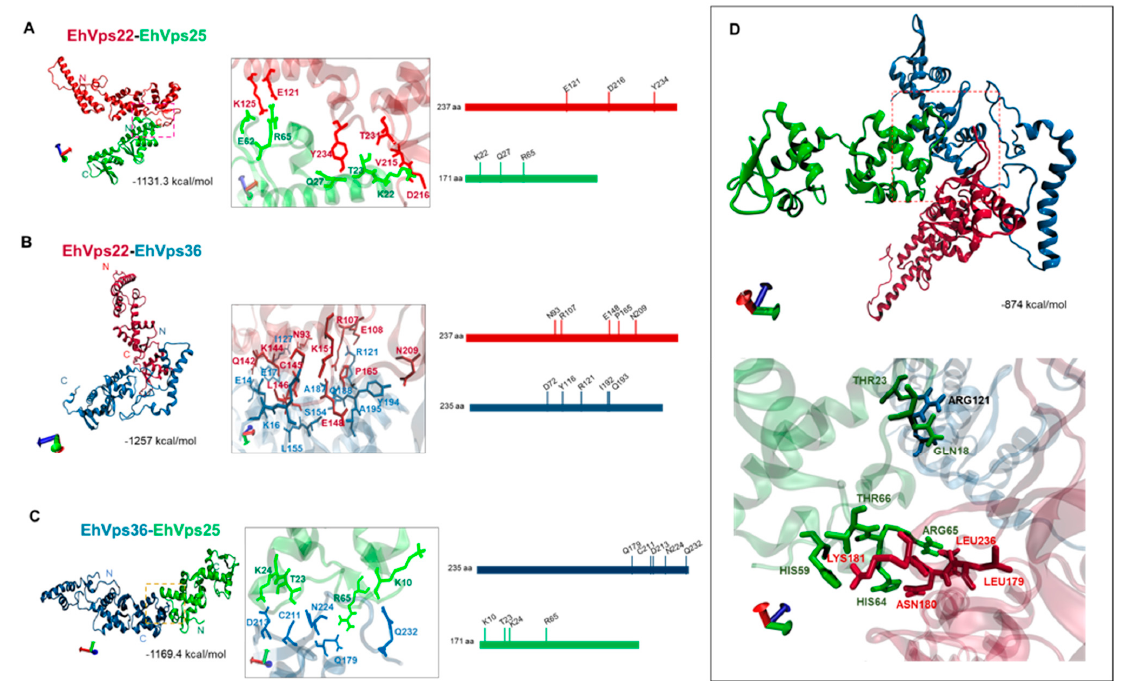
Figure 3. Molecular docking between EhVps22, EhVps25, and EhVps36 proteins. ( A ) Docking of EhVps22 with EhVps25. ( B ) Docking of EhVps22 andEhVps36. ( C ) Docking between EhVps36 with EhVps25. Right panels: zoom of the squared regions in ( A – C ) involved in binding. The next panel is the zoom; linear representation of the amino acid position involved in the association between the proteins. ( D ) In silico analysis of the three interacted proteins as a single complex. Zoom of the squared regions in ( D ).